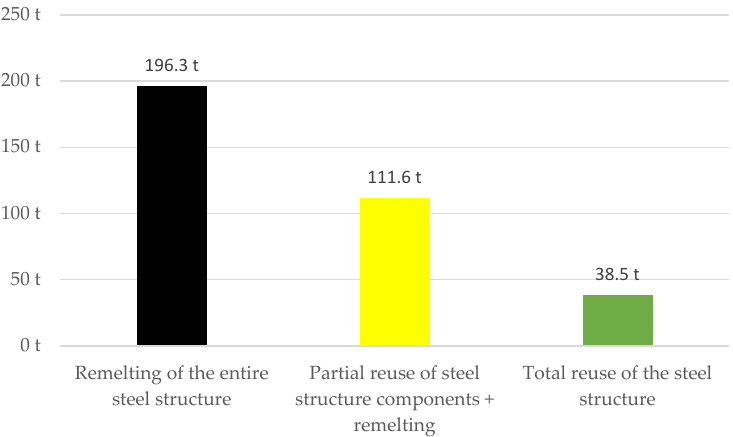
Figure 8. Refurbishment process of steel sections. Table 4. Material balance by scenarios.